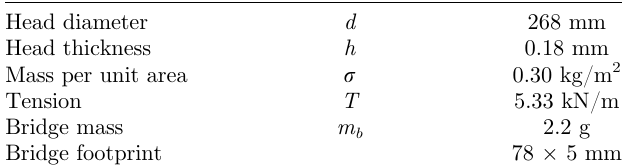
Table 1. Parameter values for the Deering banjo. Head tension is estimated from computer modelling: see the companion paper [2].